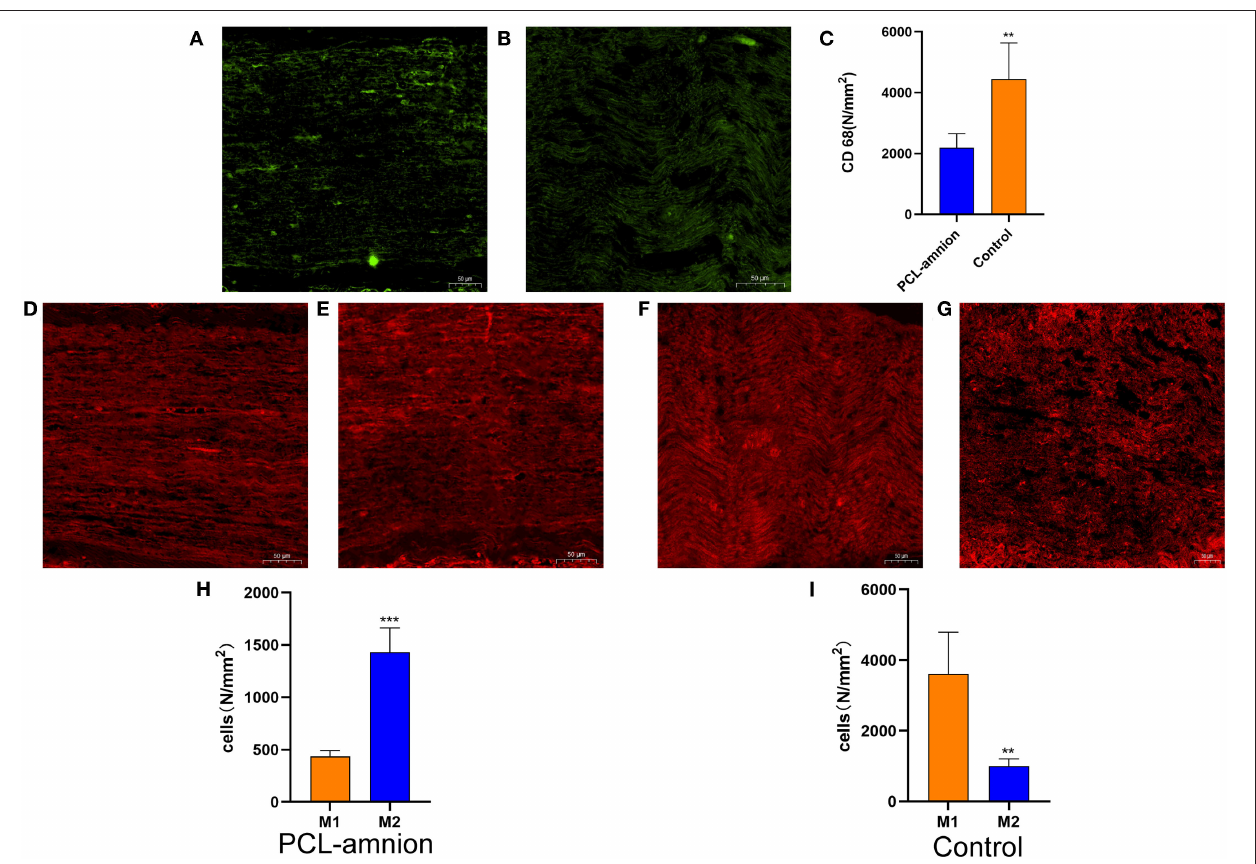
FIGURE 2 | Inflammatory reaction assessment at the repair site. (A–C) ED1 macrophages of the sciatic nerve at the repair site. (A) The PCL-amnion nanofibrous membrane group. (B) The Control group. (C) The ED1 macrophage count between the two groups were significantly different ( P < 0.05). ** P < 0.01 compared to the PCL-amnion group. (D–I) M1 and M2 of the sciatic nerve at the repair site. (D) M1 of the sciatic nerve in the PCL-amnion nanofibrous membrane group. (E) M2 of the sciatic nerve in the PCL-amnion nanofibrous membrane group. (F) M1 of the sciatic nerve in the Control group. (G) M2 of the sciatic nerve in the Control group. (H) The M1:M2 ratio in the PCL-amnion nanofibrous membrane group was 1:3 ( P < 0.05). *** P < 0.001 compared to M1. (I) The M1:M2 ratio in the Control group was 3:1 ( P < 0.05). ** P < 0.01 compared to M1.